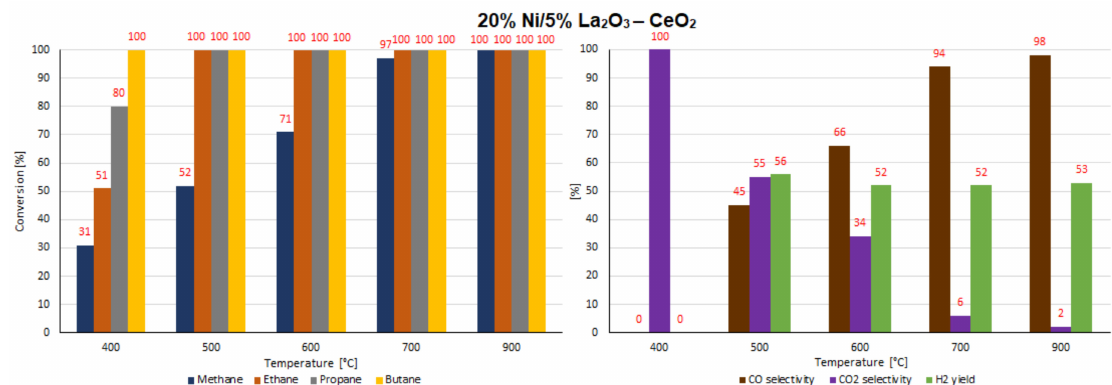
Figure 17. The activity results of the 20% Ni/5% La 2 O 3 –CeO 2 catalyst in the OSR-LNG process.